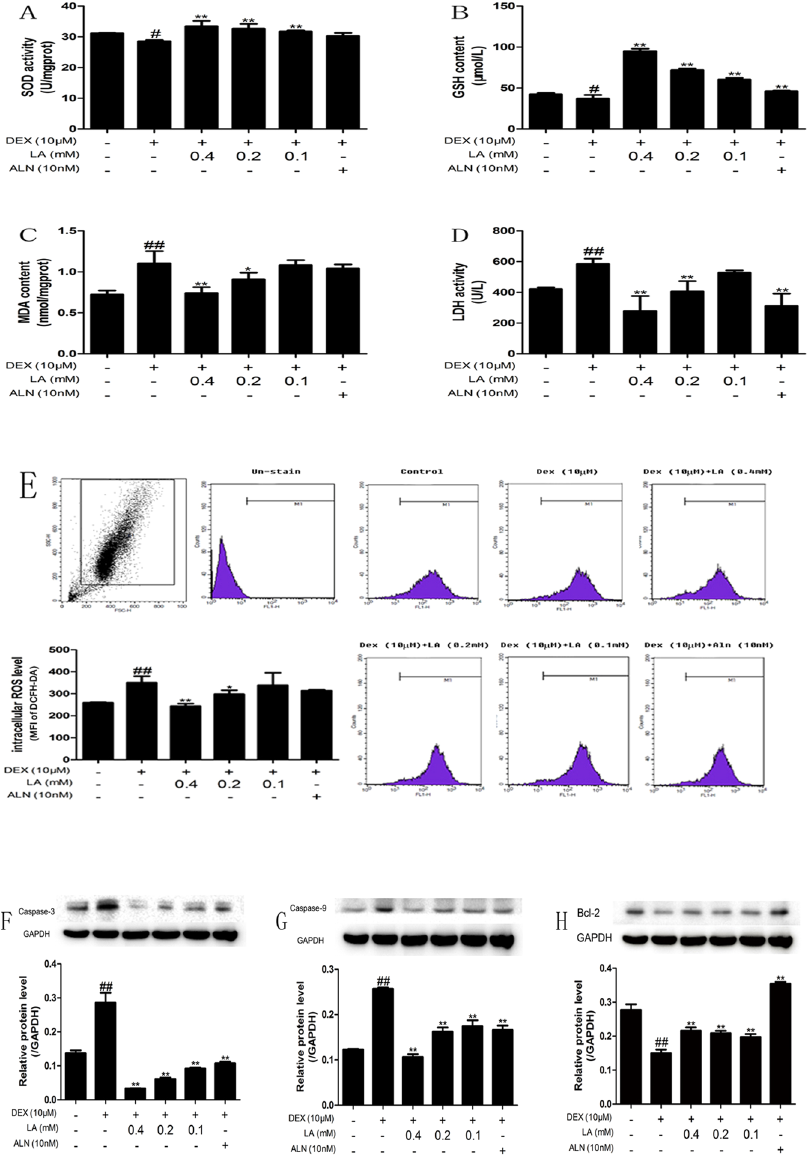
Figure 6. Effects of LA on biochemical parameters of oxidative stress in MC3T3-E1 cell. Cells were treated with LA or ALN while being treated with DEX. SOD ( A ), GSH ( B ), MDA ( C ) and LDH ( D ) were detected by assay kit. LA scavenged the excessive generation of intracellular ROS ( E ) stimulated by DEX. All experiments were performed three times with identical results. # p < 0.05 and ## p < 0.01 compared with the control group. * p < 0.05, ** p < 0.01 compared with the DEX-alone group. The expression levels of apoptosis proteins (Caspase-3, Caspase-9, Bcl-2) in MC3T3-E1 cells. Caspase-3 ( E ), Caspase-9 ( F ), Bcl-2 ( G ) were detected by western blotting. GAPDH was used as the loading control. All experiments were performed three times with identical results. # p < 0.05 and ## p < 0.01 compared with the control group. * p < 0.05, ** p < 0.01 compared with the DEX-alone